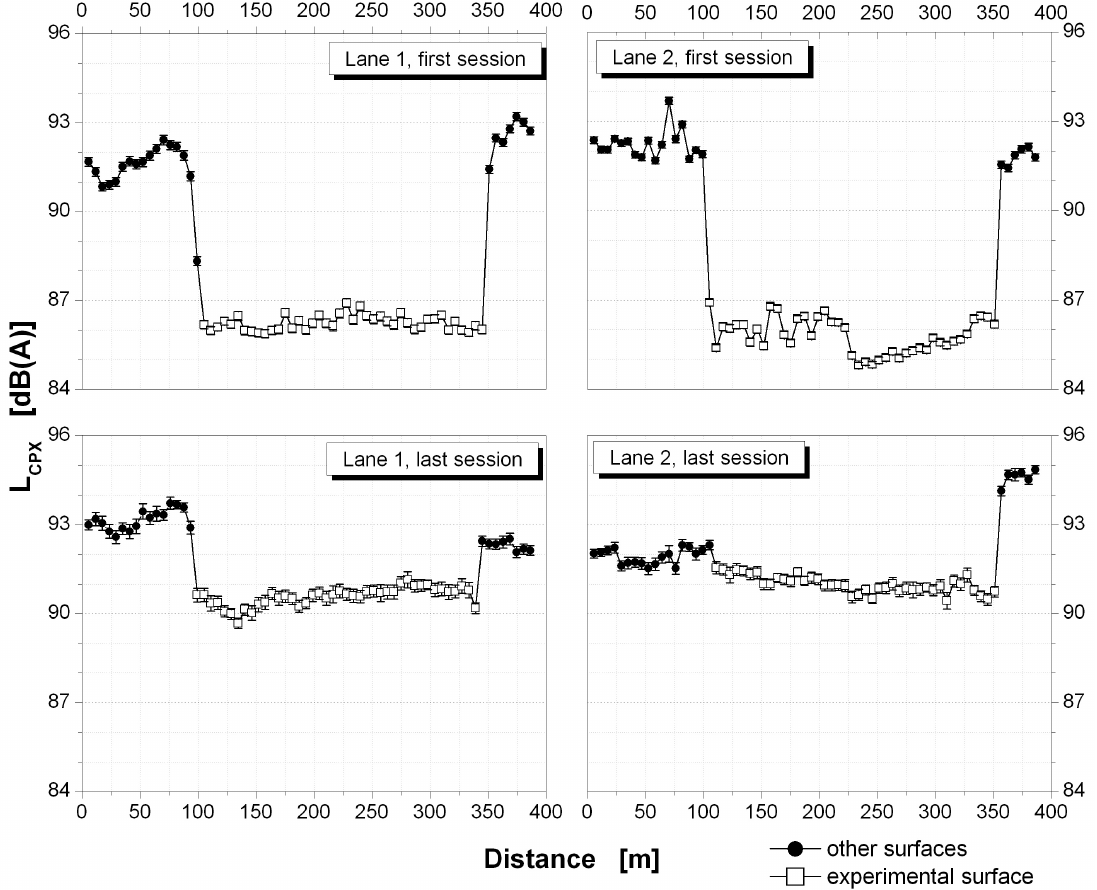
Figure 8. CPX data spatial distribution obtained during first session (upper figures) of measurements and during last one (lower figures) at Site 2. Lane 1 results are represented on the left plots while lane 2 ones are on the right plots. Experimental stretches data are marked with white